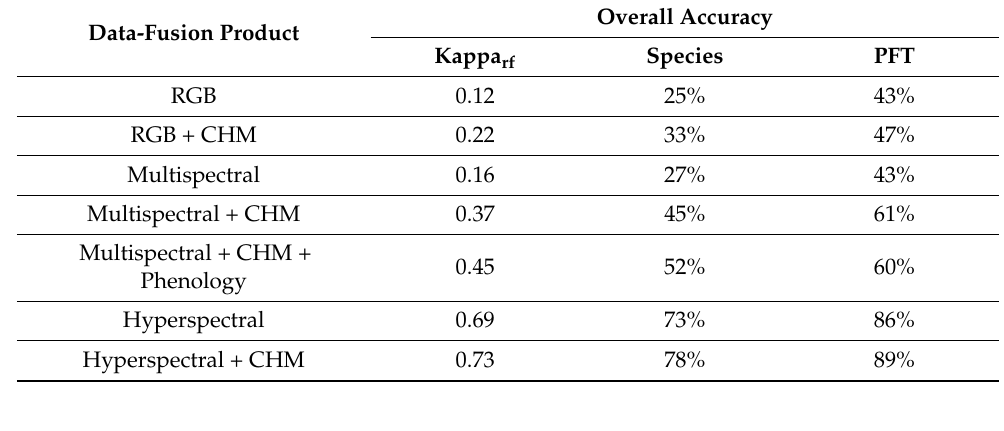
Table 6. Summary of the overall accuracy and Kappa coefficients of random forest mapping of 10 plant species and 5 plant functional types (PFTs) as computed from confusion matrices.